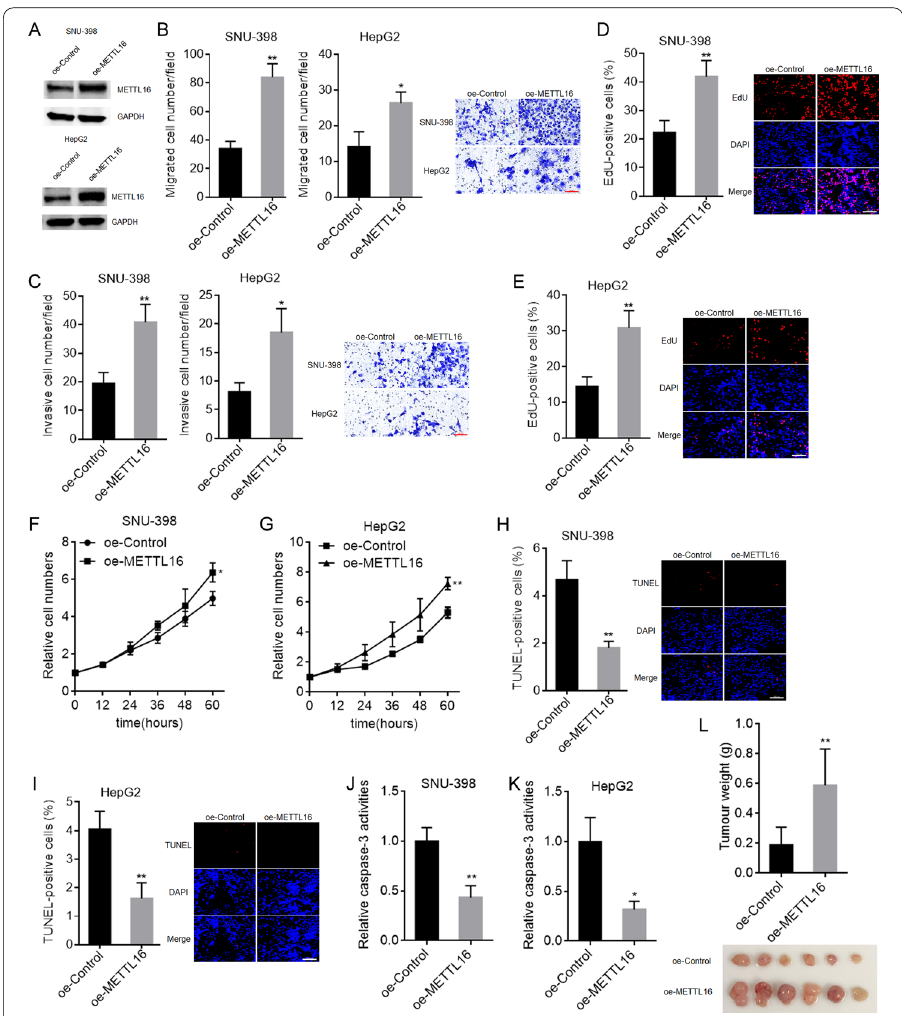
Fig. 2 The roles of METTL16 overexpression in HCC. A METTL16 protein expression in SNU‑398 and HepG2 cells with METTL16 overexpression or control was detected by western blot. B Migration ability of SNU‑398 and HepG2 cells with METTL16 overexpression or control was detected by transwell migration assay. Scale bars, 100 µm. C Invasion ability of SNU‑398 and HepG2 cells with METTL16 overexpression or control was detected by transwell invasion assay. Scale bars, 100 µm. D Cellular proliferation of SNU‑398 cells with METTL16 overexpression or control was detected by EdU assay. Scale bars, 100 µm. E Cellular proliferation of HepG2 cells with METTL16 overexpression or control was detected by EdU assay. Scale bars, 100 µm. F Cellular proliferation of SNU‑398 cells with METTL16 overexpression or control was detected by CCK‑8 assay. G Cellular proliferation of HepG2 cells with METTL16 overexpression or control was detected by CCK‑8 assay. H Cellular apoptosis of SNU‑398 cells with METTL16 overexpression or control was detected by TUNEL assay. Scale bars, 100 µm. I Cellular apoptosis of HepG2 cells with METTL16 overexpression or control was detected by TUNEL assay. Scale bars 100 µm. J Cellular apoptosis of SNU‑398 cells with METTL16 = overexpression or control was detected by caspase‑3 activity assay. K Cellular apoptosis of HepG2 cells with METTL16 overexpression or control was detected by caspase‑3 activity assay. L Weight and photograph of subcutaneous tumors formed by SNU‑398 cell with METTL16 overexpression or control. Results are shown as mean SD of n 3 independent experiments ( B – K ) or n 6 mice in each group ( L ). * P < 0.05, ** P < 0.01 by ± = = Student’s t ‑test ( B – K ) or Mann–Whitney test ( L